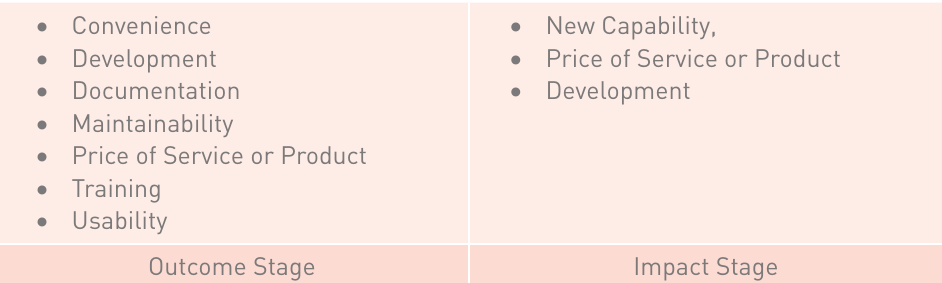
Distributed Success